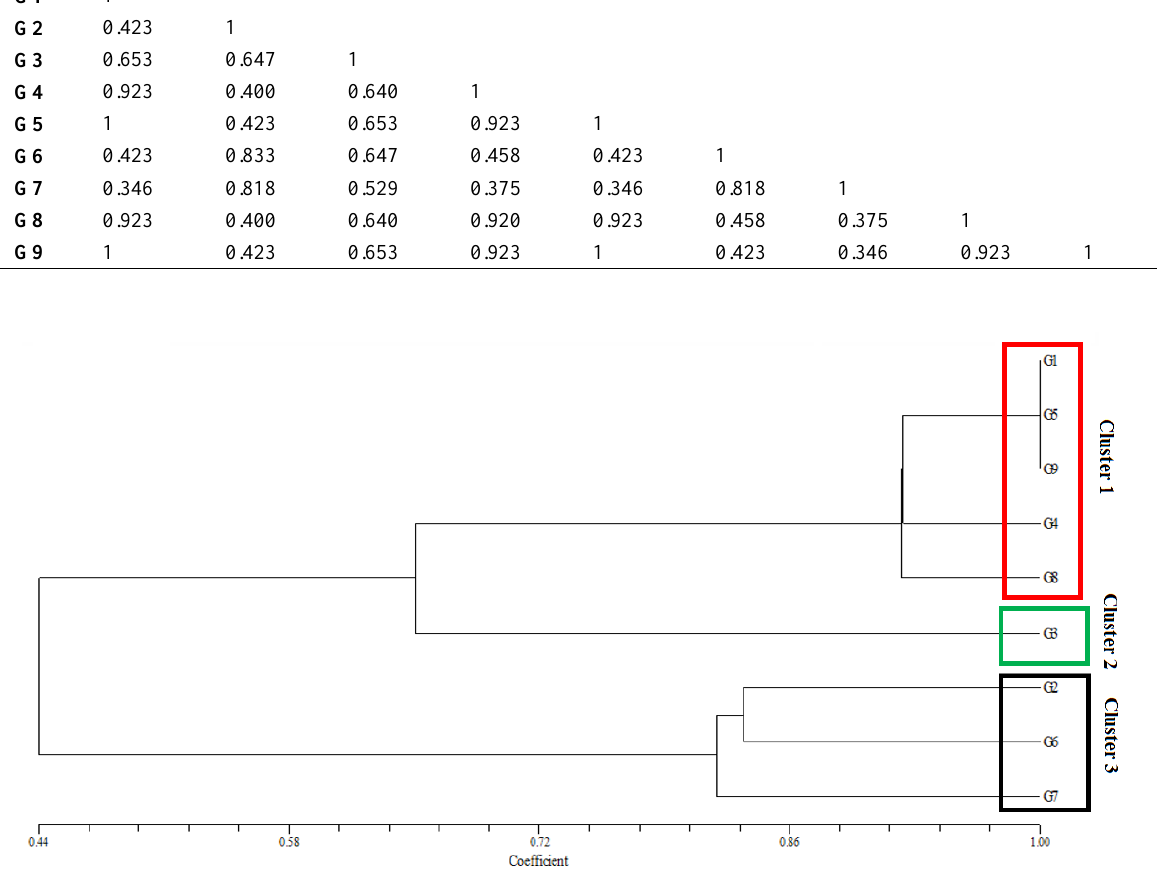
Fig. 2. UPGMA cluster analysis based on seed storage pattern.